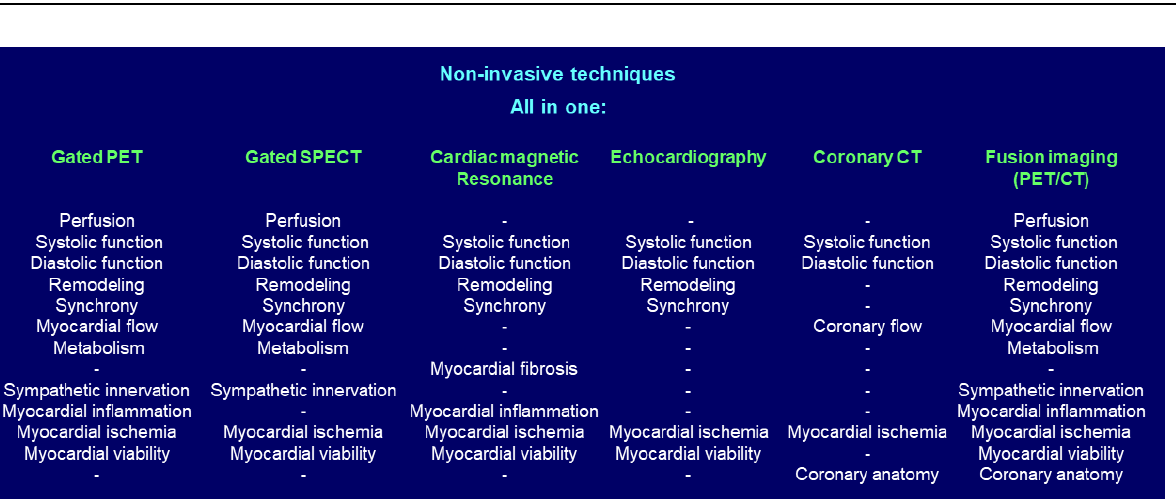
Figure 4. The different non-invasive techniques to evaluate patients with scCAD provide additional information in the same study.